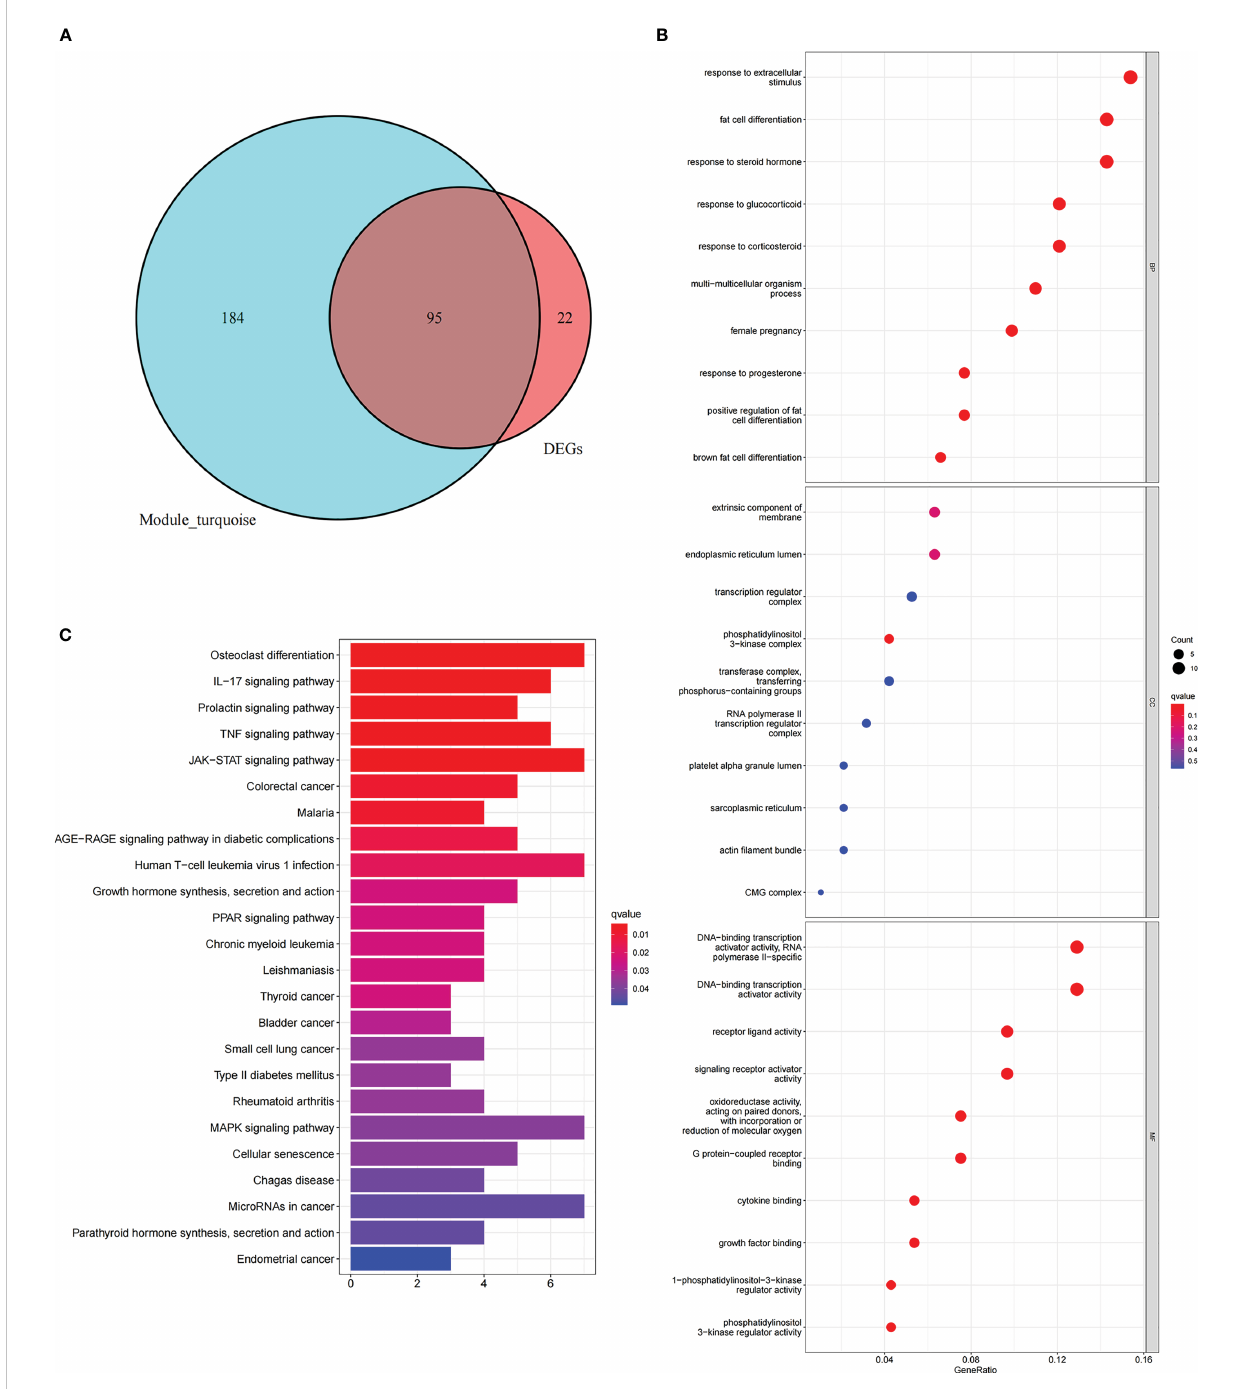
FIGURE 5 Functional enrichment analysis of intersection genes in NAFLD. (A) With reference to the Venn diagram, the turquoise module of NAFLD and the DEGs of NAFLD contain 95 intersection genes. (B) GO enrichment analysis of the intersecting genes. The X-axis represents the gene ratio for each term, while the Y-axis refers to the different terms in GO. The p-value is indicated as the color of the circle, and the circle size indicates the number of genes for the corresponding item. (C) The KEGG pathway enrichment analysis results of the intersecting